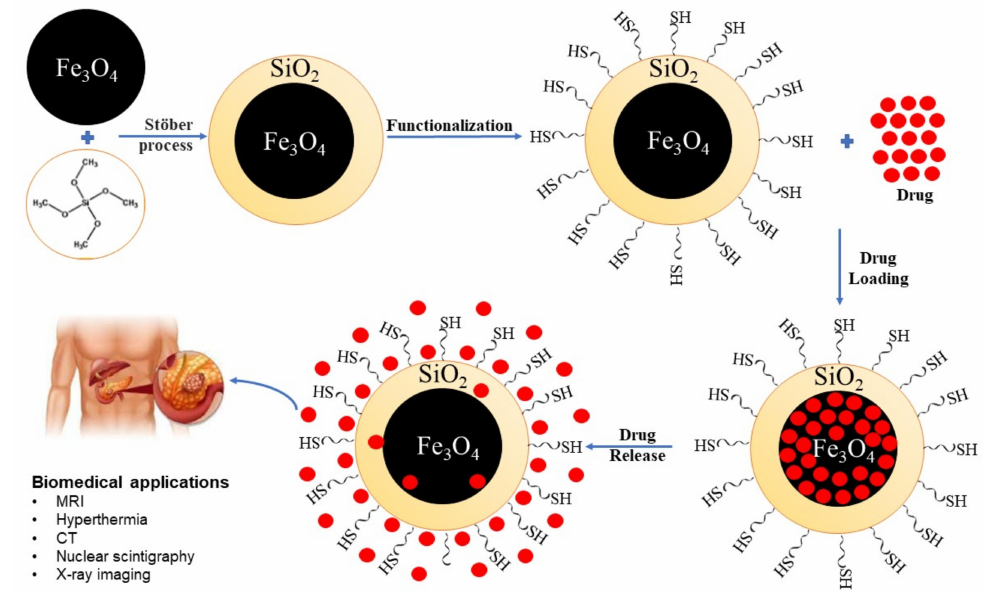
Figure 4. Graphical representation of biomedical